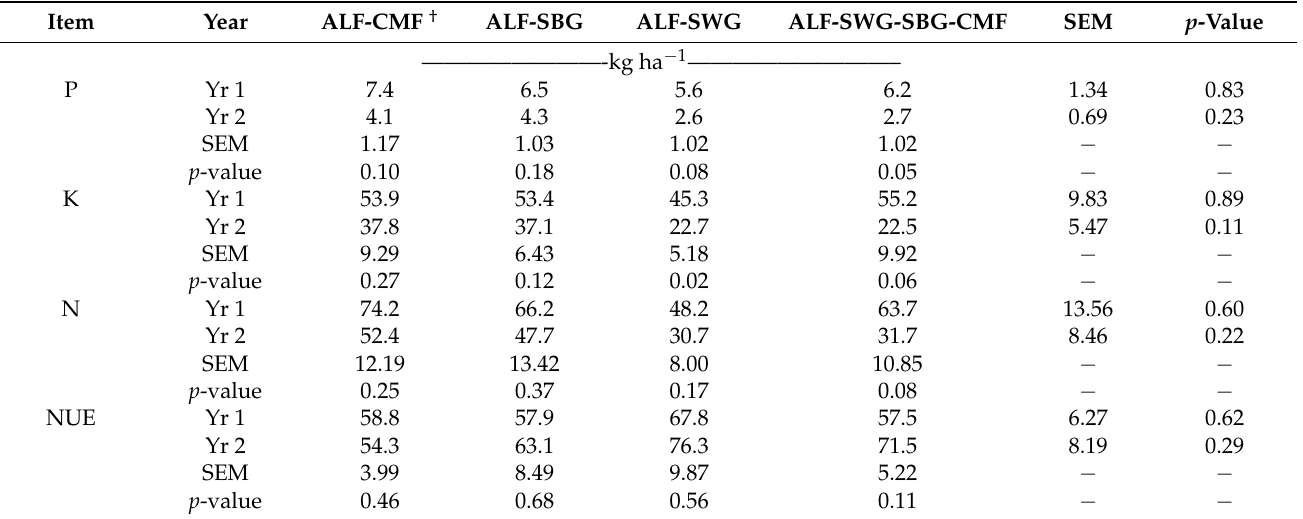
Table 7. Nutrient uptake of ‘Halo’ alfalfa and grass mixtures in Clavet, Saskatchewan, Canada over 2 yrs